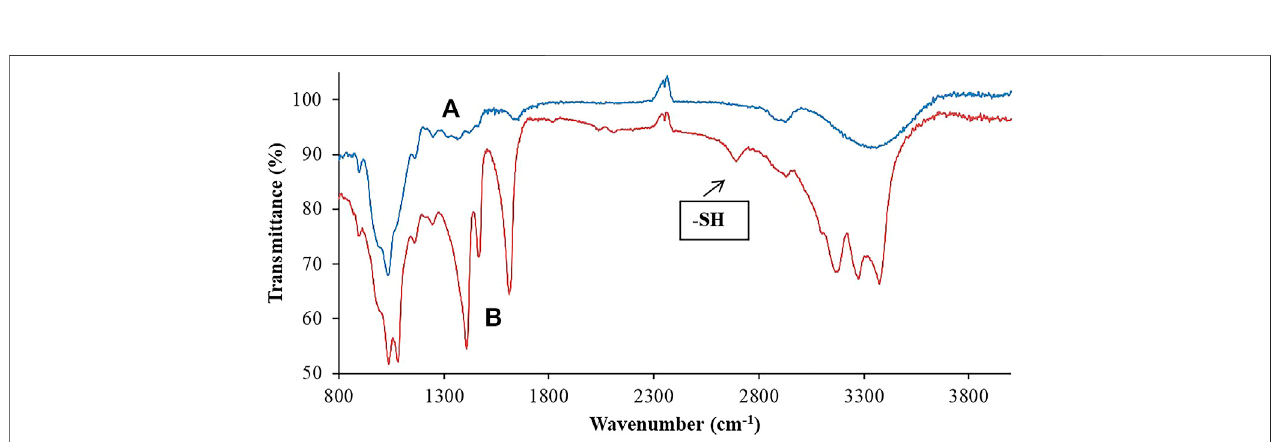
FIGURE 4 | Comparative illustration through FTIR scans of both (A) hemicellulose and (B) thiolated hemicellulose, con fi rming the occurrence of chemical changes in the structure of hemicellulose.